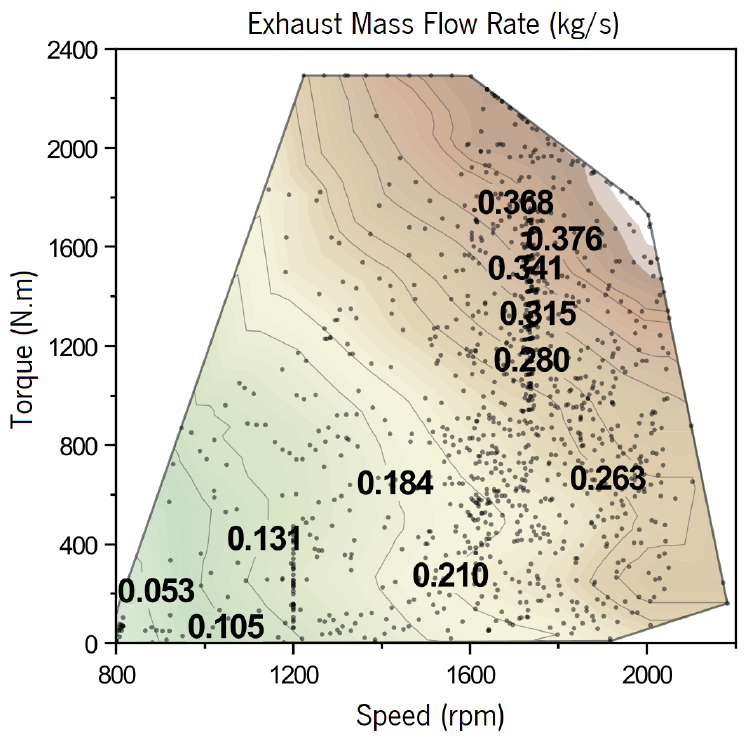
Figure 8. Exhaust gas contour map: exhaust gas mas flow rate at the aftertreatment